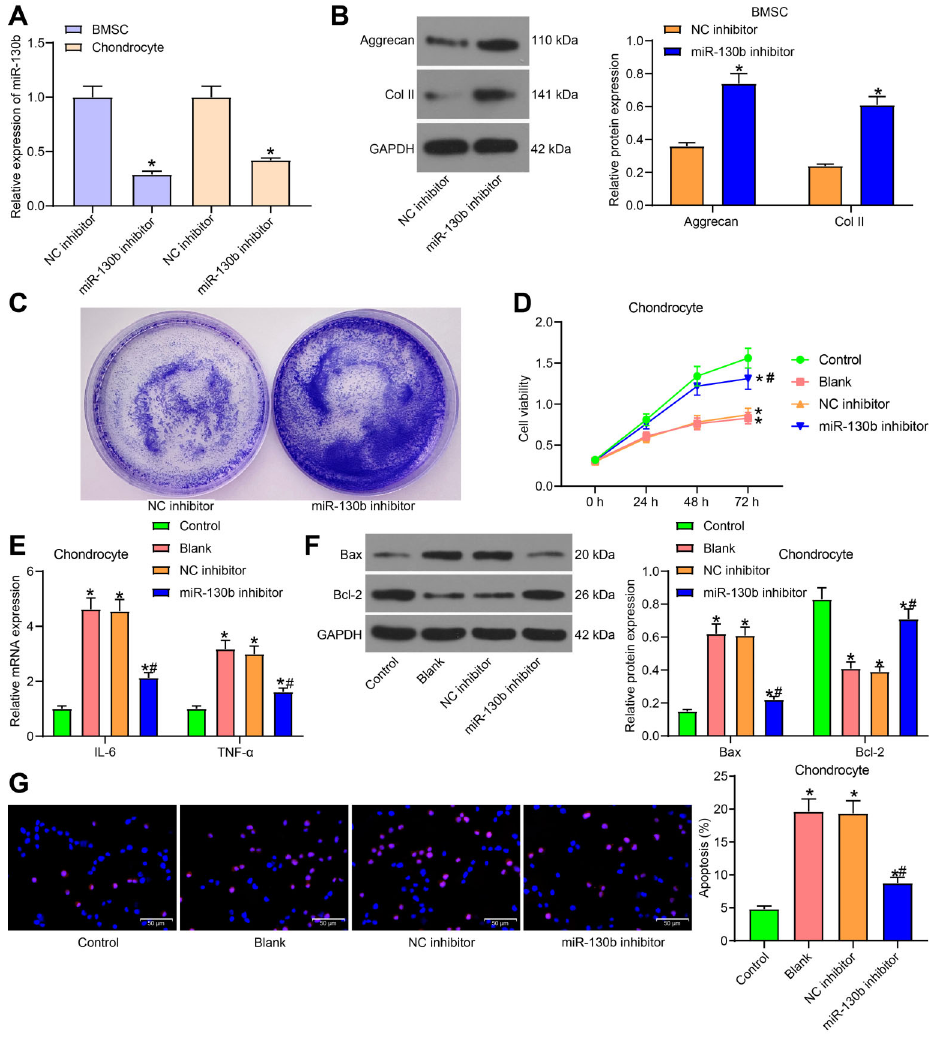
Figure 2. Inhibition of miR-130b promotes chondrogenic differentiation of bone marrow mesenchymal stem cells (BMSCs) and chondrocyte growth. A , The transfection ef fi ciency of miR-130b inhibitor was veri fi ed by RT-qPCR. B , Western blot analysis measured the expression of two cartilage markers in BMSCs. C , The synthesis of extracellular matrix during chondrogenesis of BMSCs was examined by toluidine blue staining. D , MTT method was used to measure the viability of interleukin (IL)-1 b -stimulated chondrocytes. E , IL-6 and tumor necrosis factor (TNF)- a expression in IL-1 b treated chondrocytes was determined by RT-qPCR. F , Levels of apoptosis- related proteins in IL-1 b -treated chondrocytes were measured by western blot analysis. G , Apoptosis rate in IL-1 b -treated chondrocytes was measured by TUNEL assay (scale bar, 50 m m). *P o 0.05, compared to control; # P o 0.05 compared to the NC inhibitor group. The data in panels A and G were analyzed using one-way ANOVA, and the data in panels B, D, E, and F were analyzed using two-way ANOVA. Experiments were repeated 3 times independently. NC: negative